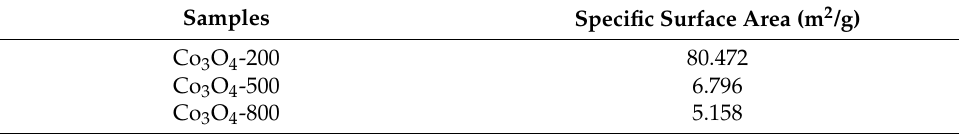
Figure 2. SEM image of samples including ( a ) Co(OH) 2 , ( b ) Co 3 O 4 -200, ( c ) Co 3 O 4 -500, and ( d ) Co 3 O 4 -800. Table 1. Specific surface area of the samples .